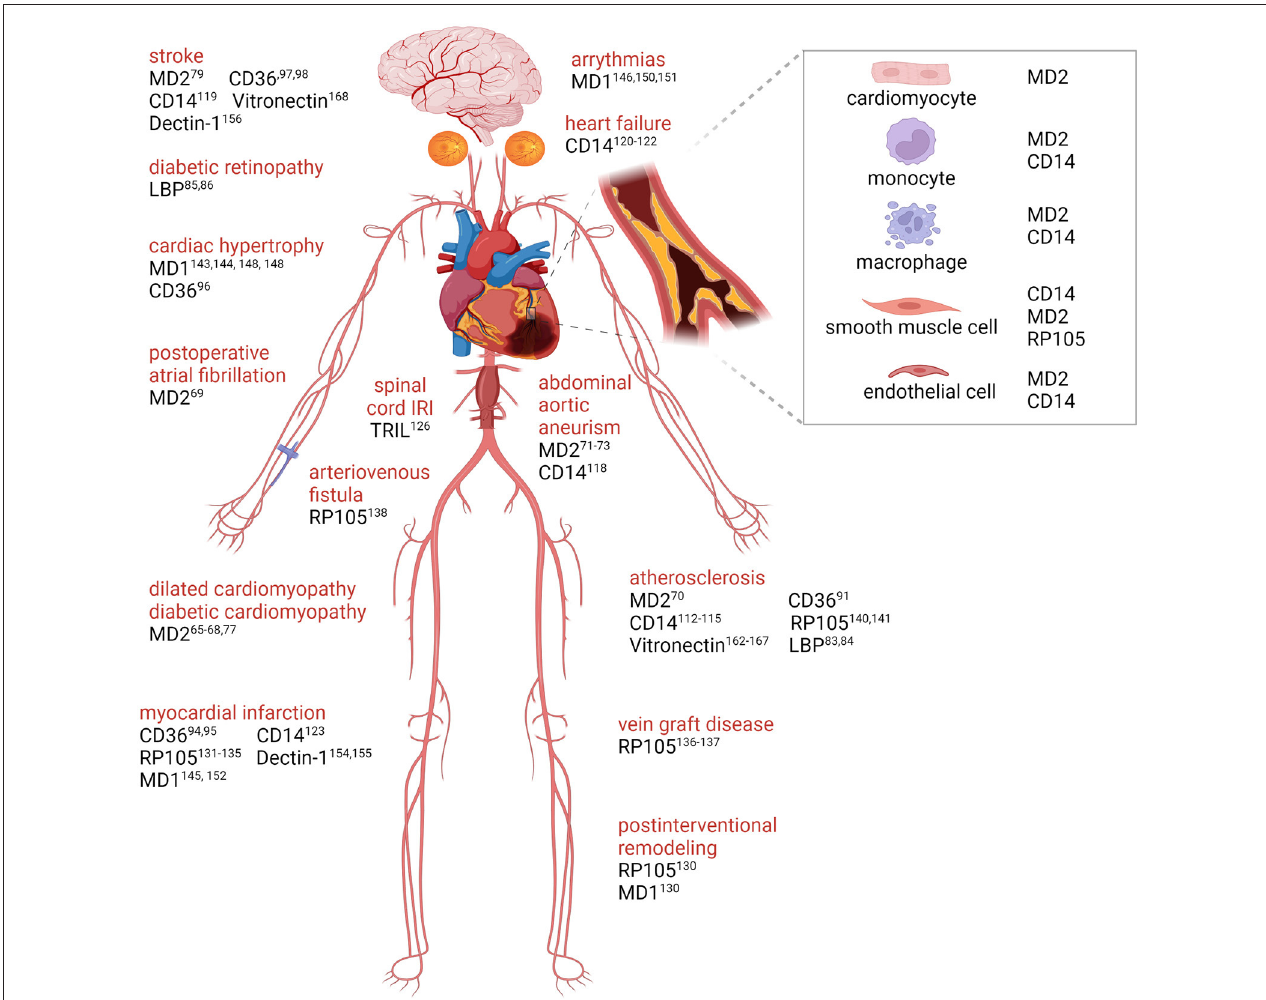
FIGURE 2 | TLRs accessory molecules in cardiovascular disease. Graphical overview with supporting literature references underlying the role of accessory molecules for membrane TLRs that are involved in cardiovascular disease progression. Created with BioRender.com.